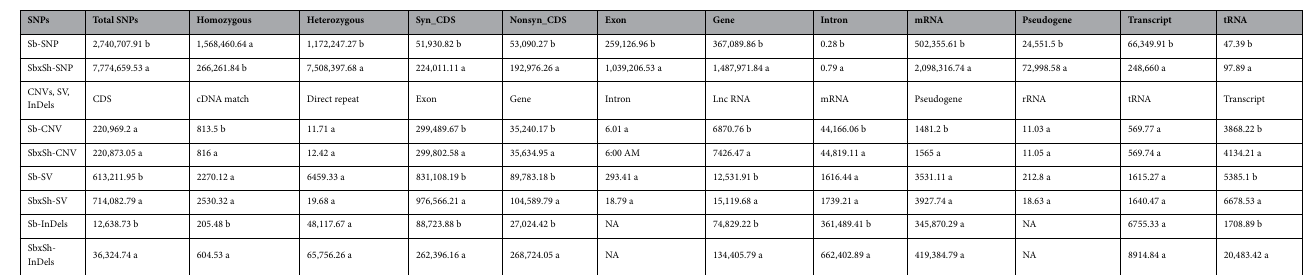
Table 1. Tukey HSD for SNPs, InDels, SVs, and CNVs in S. bicolor vs. S. bicolor × S. halepense results. *Numbers followed by same letter within a column and for same variant, are not statistically different at the 5% probability